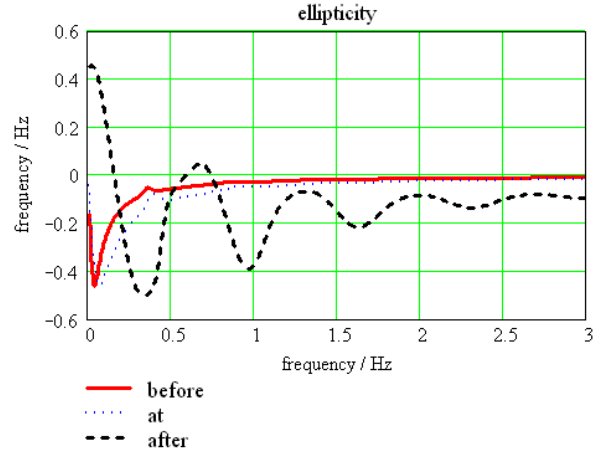
Fig. 6. The ellipticity (cid:15) as a function of frequency for three in- stances of time as given by the relative distance of the terminator to the nominal zero-line; before ( L = − 2), at ( L =0), and after ( L = +